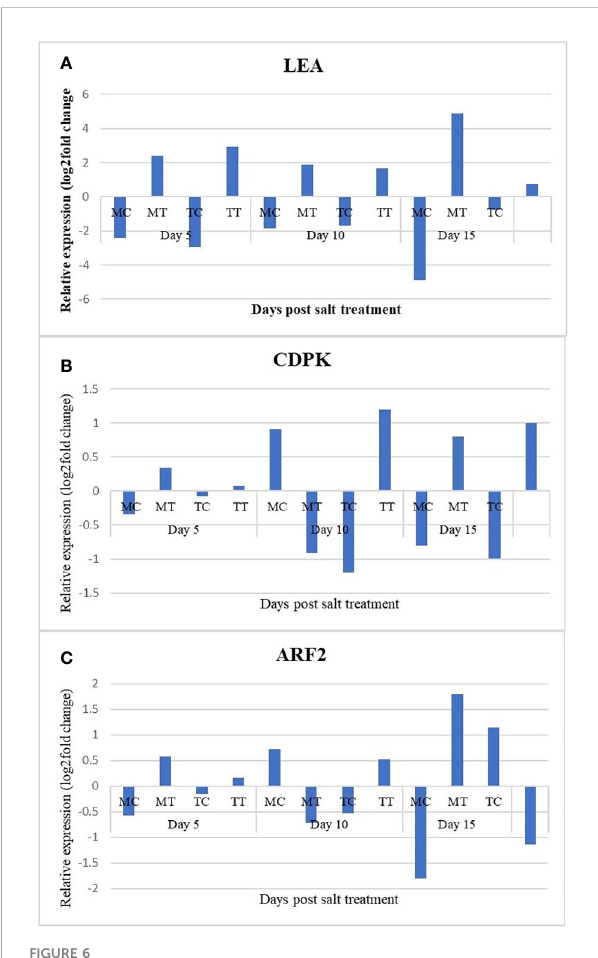
FIGURE 6 (A – C) Expression pro fi les of LEA, CDPK and ARF2 over different time points of salt stress (NaCl at the rate of 50mM) in leaves of mango genotypes Turpentine and Mylepelian in three comparisons. Mylepelian Treated (MT) vs. Mylepelian Control (MC); Mylepelian Treated (MT) vs. Turpentine Treated (TT) and Turpentine Control (TC) vs. Turpentine Treated (TT).x-axis: Days post salt treatment; y axis: Relative expression (log2fold change.Relative gene expression was calculated using 2 − DD CT method (fold change). * Signi fi cant differences for p-values <